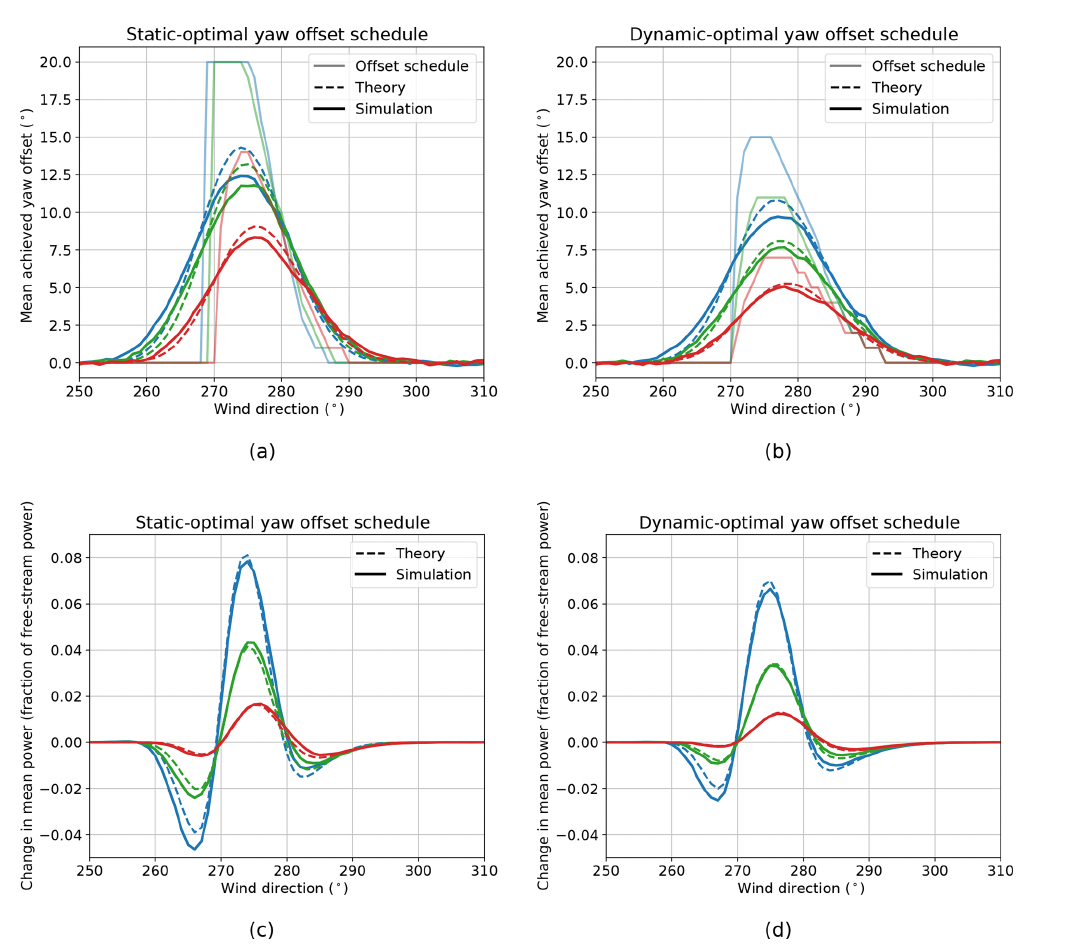
Figure 13. Mean achieved yaw offsets using offset schedules optimized for (a) static and (b) dynamic wind directions as well as change in mean power produced by the turbine pair from wake steering using offset schedules optimized for (c) static and (d) dynamic wind directions as a function of low-frequency wind direction for turbulence intensity values of 5% (blue), 10% (green), and 15% (red). Achieved theoretical and simulation-based offsets and power gains are shown for dynamic wind directions, along with the yaw offset schedules. A turbine spacing of 5 D is used in the FLORIS